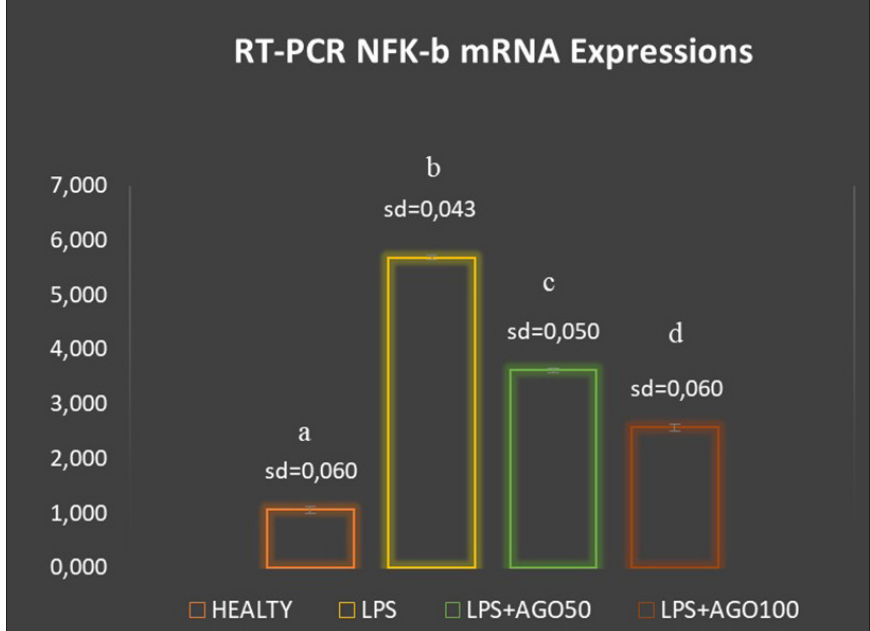
Figure 3. The effects of agomelatine on NF- κ B mRNA expressions of lung tissue. Gene expression was detected by quantitative RT-PCR analysis. The results were normalized to b-actin (housekeeping gene control). The relative expression levels were calculated by the 2-ΔΔcT method and were indicated as “fold change” compared with control groups. The results are means ± SD. Means that have the same letter are not significantly different to those of the test of Duncan (P = .05). LPS: lipopolysaccharide, AGO: agomelatine, SD: standard deviation, RT-PCR: real-time polymerase chain